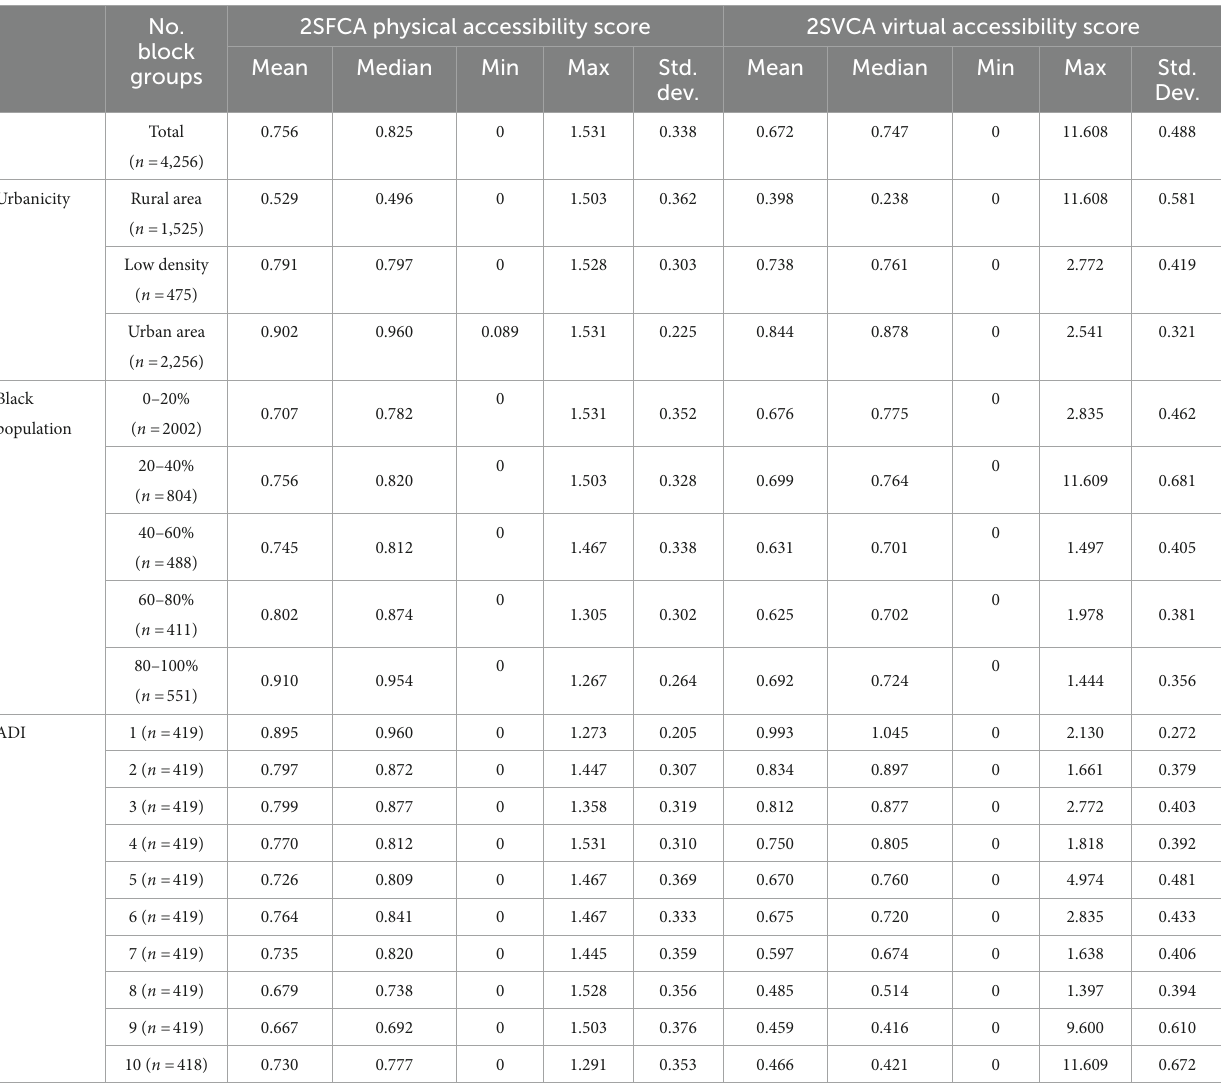
TABLE 2 Physical and virtual accessibility by urbanicity, Black population and